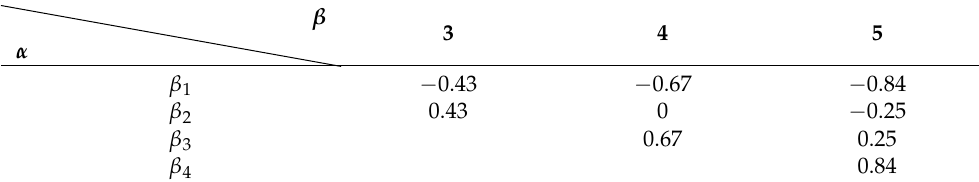
Table 3. The value table of break